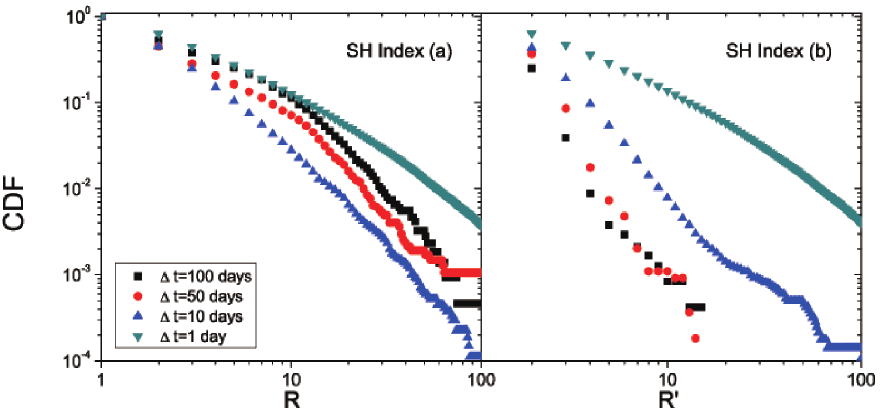
Figure 5. Same as Fig. 3, but for the SH Index in the Chinese stock market. Regarding the fitting, more details are listed in Table 3.